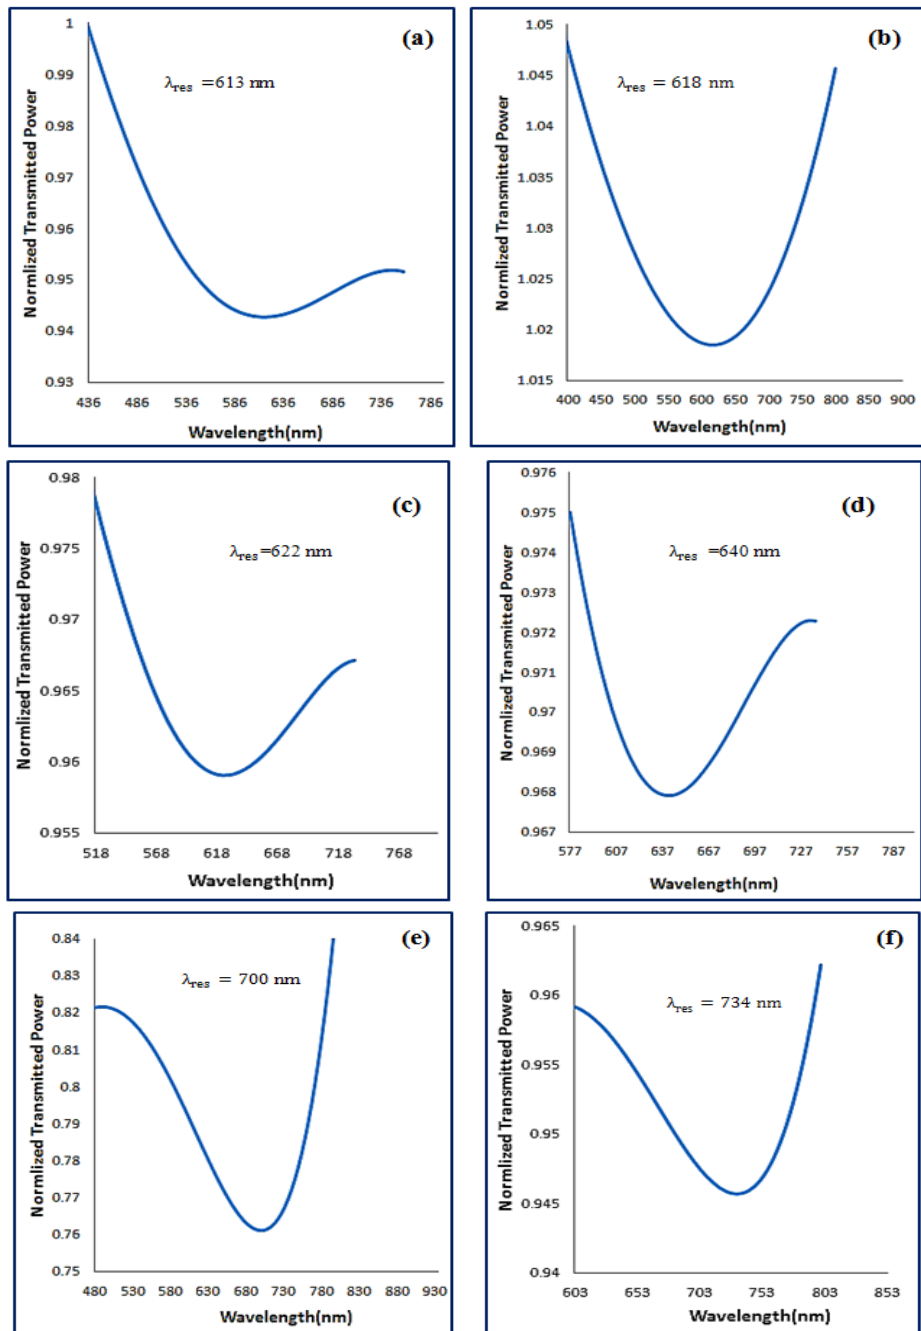
Fig.10: SPR curve of the optical fiber sensor with a gold metal of different samples of blood